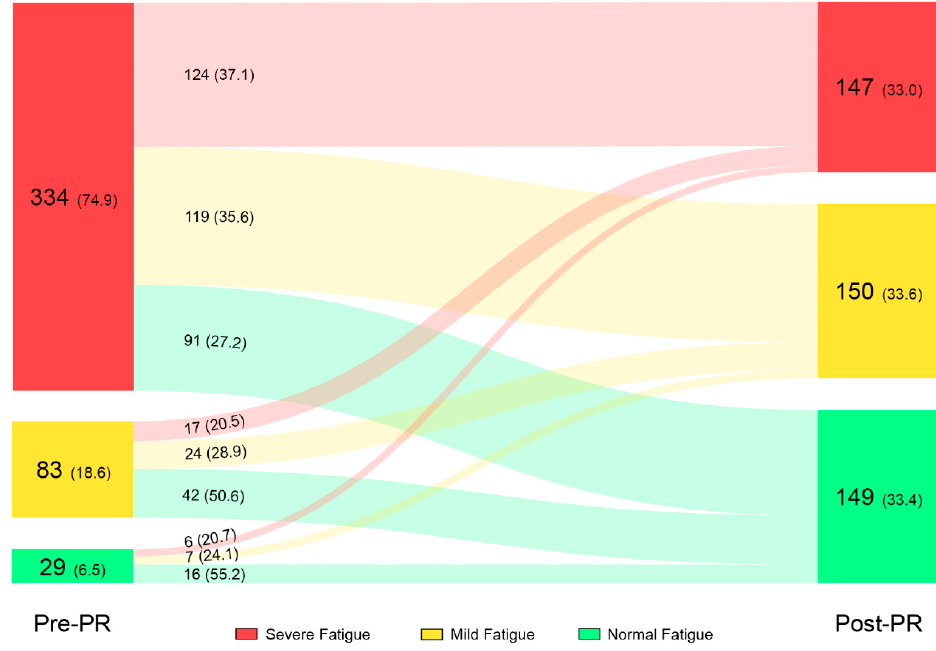
Figure 1. Prevalence of patients with normal, mild and severe fatigue before and after PR, and change